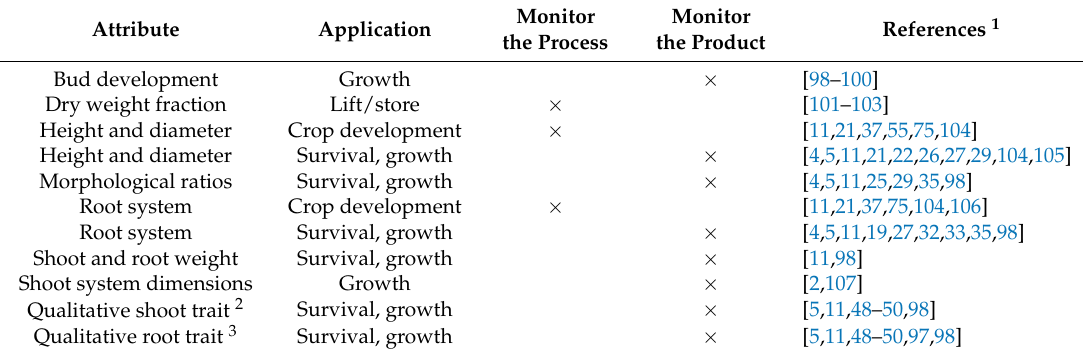
Table 2. Morphological attributes commonly used in seedling quality assessment programs to monitor either the process during nursery culture or the product at the end of culture.